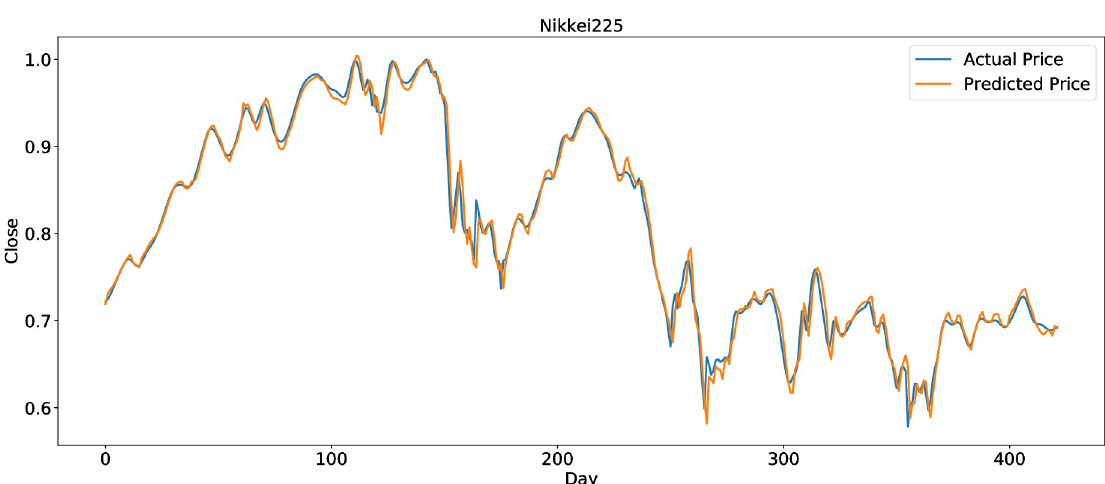
Fig 15. Prediction results of Nikkei225 data set.